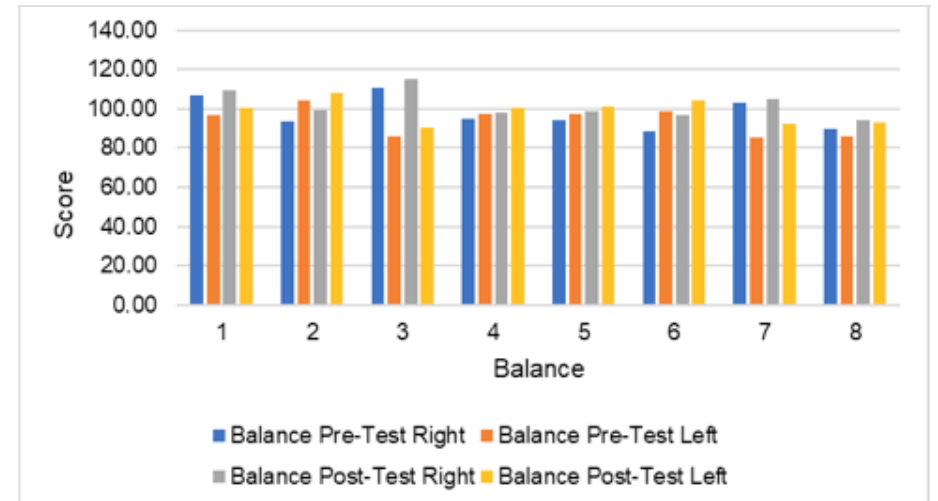
Figure 3. Data of balance theraband exercise 16 years old